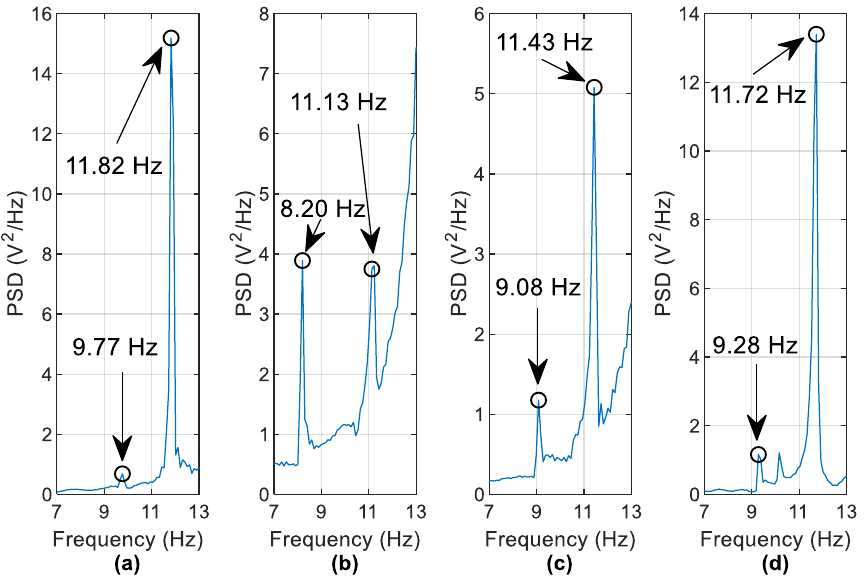
Figure 17. Averaged PSDs of 10 runs ( a ) Healthy case ( b ) 44.9% scour at pier 2 ( c ) 24.5% scour at pier 2 ( d ) 24.5% scour at pier 3.